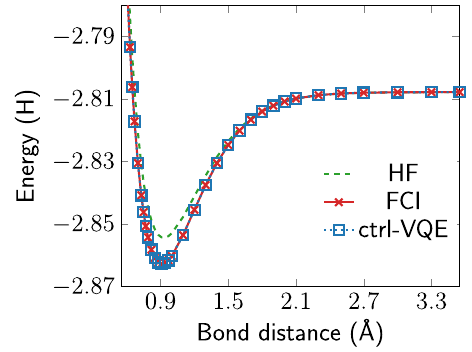
Fig. 2 Bond dissociation curve of HeH + molecule. ctrl-VQE energies are computed using square pulses with two time